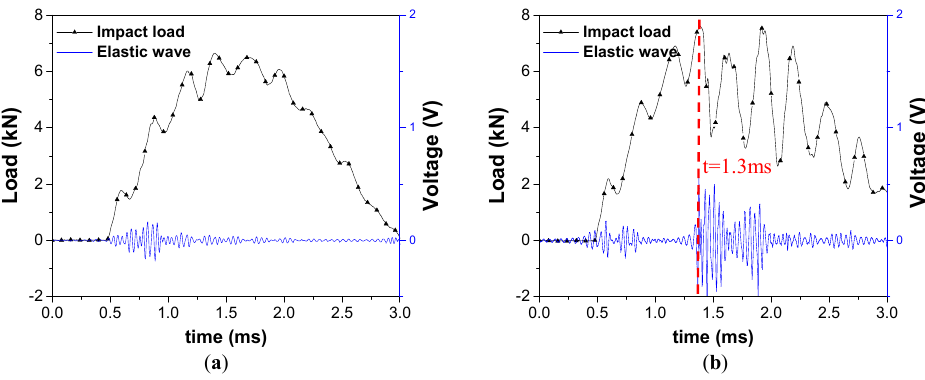
Figure 9. Graphs of elastic waves due to impact load: ( a ) impact energy-9 J, R-4 mm (intact) and ( b ) impact energy-12 J, R-4 mm (damaged).